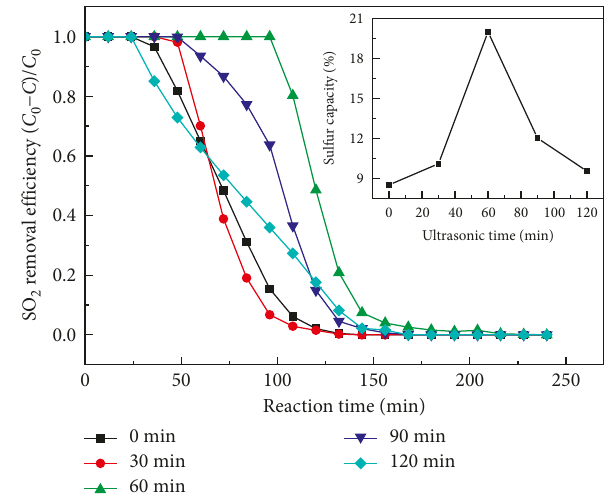
Figure 3: XRD pattern of zinc ferrite/activated carbon at different mass ratios.